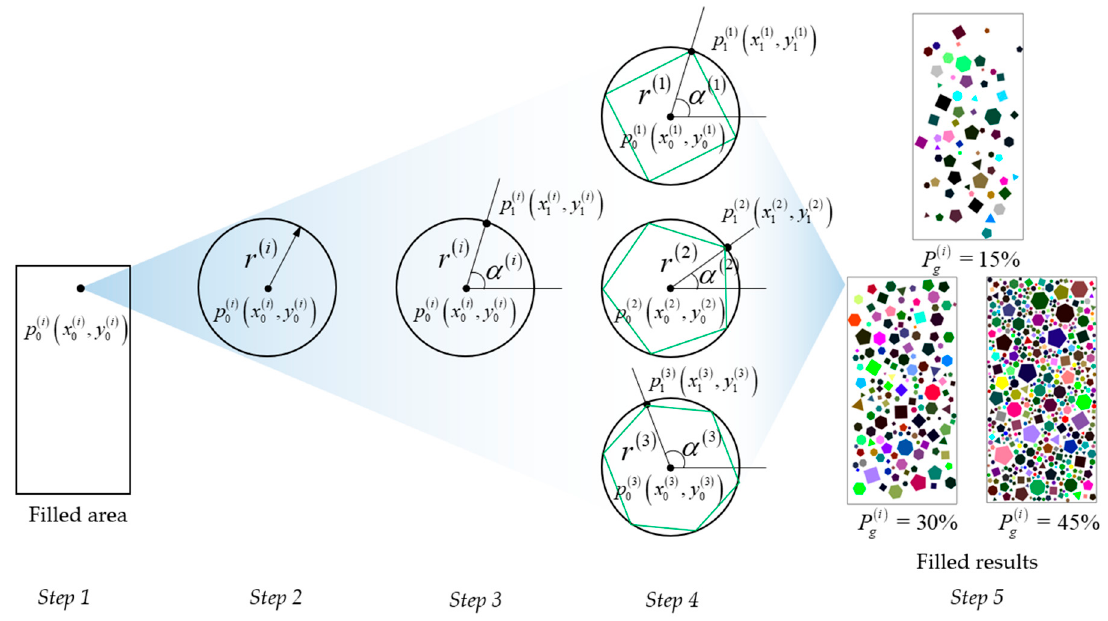
Figure 6. Generation process of pebbled sandstone samples.